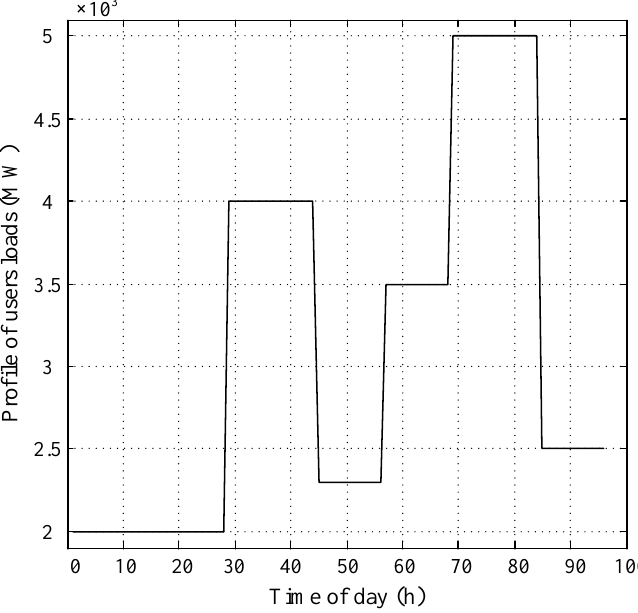
Figure 2. Daily load curve of users.